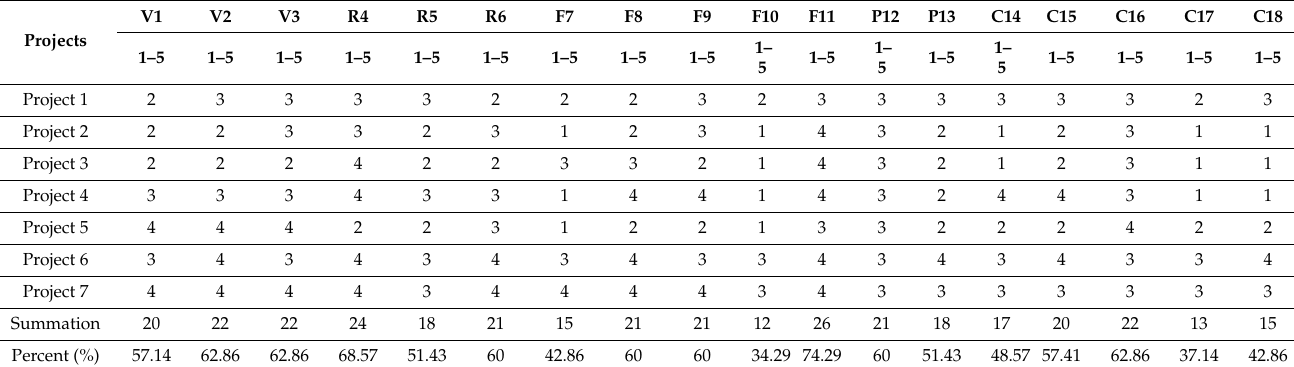
Table 7. Decision matrix (Lean driver vs. Different